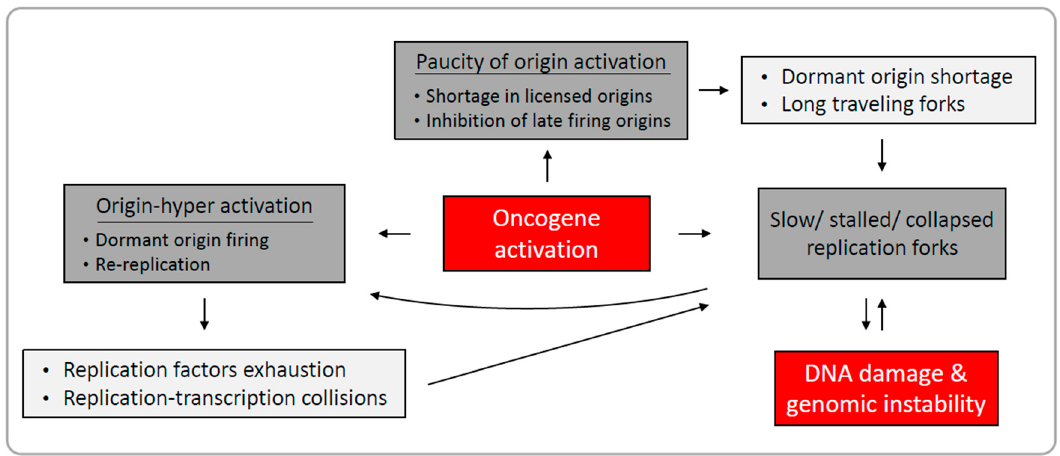
Figure 1. Oncogene-induced replication stress leads to DNA damage and genomic instability. Oncogene activation disrupts replication regulation leading to slow and stalled replication forks, hyper-activation and/or paucity of origin activation. Such deregulated replication causes DNA damage. Dark grey boxes are manifestations of deregulated replication, light grey boxes are the potential outcomes of origin deregulation.